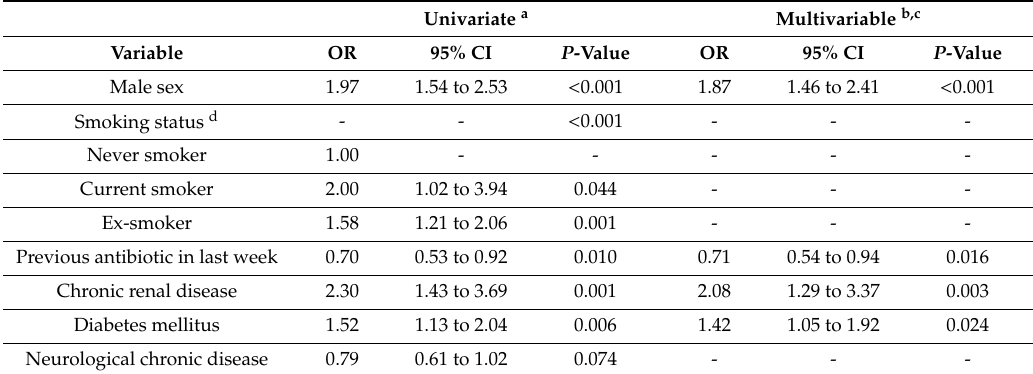
Table 2. Significant risk factors for sepsis in the logistic regression analyses ( n =